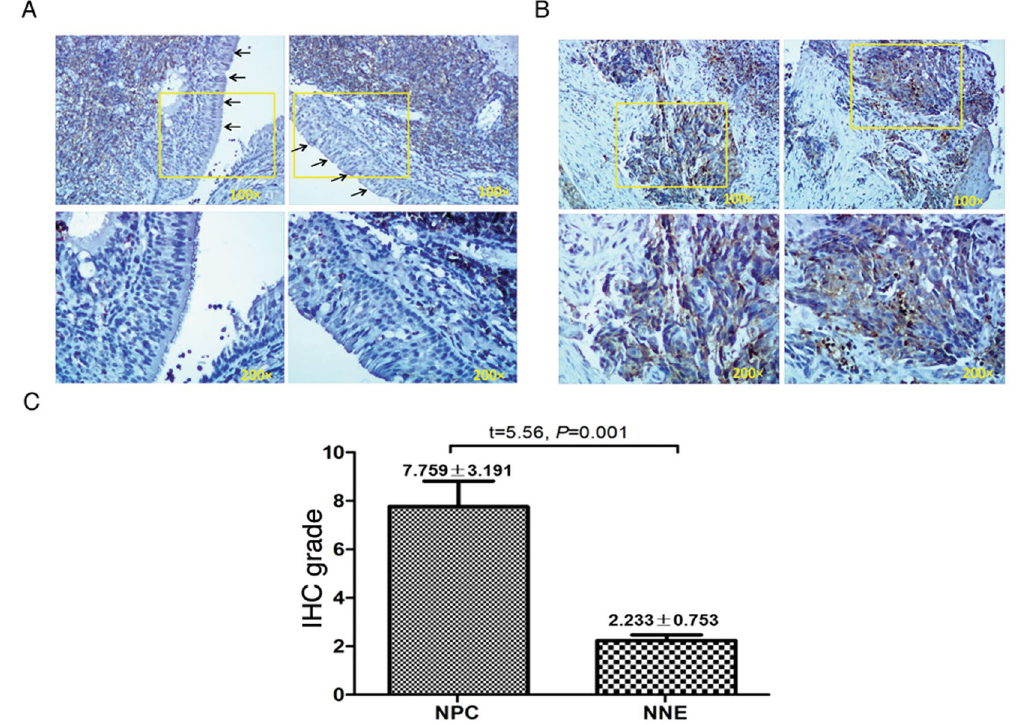
Figure 6. Nasopharyngeal carcinoma (NPC) samples express significantly more cofilin than normal nasopharyngeal epithelium (NNE). Representative IHC slides of cofilin stained NNE ( A ) and NPC ( B ) samples are shown. Black arrows denote NPC tissue. Panel C Staple diagram shows the statistical analysis of cofilin expression in NPC and NNE